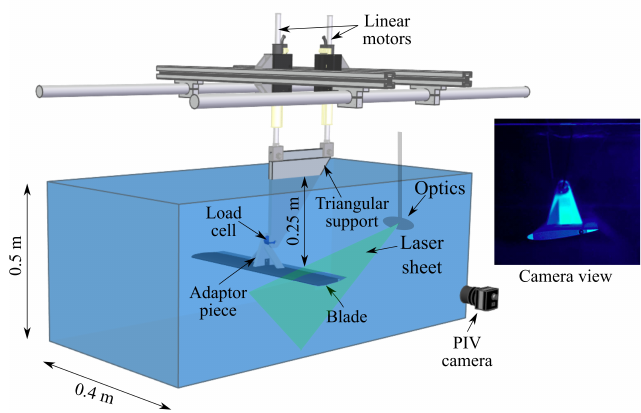
Fig. 5: Schematic diagram of the experimental setup to test the foil with flap in the water tunnel. The camera view shows the morphing model at its equilibrium